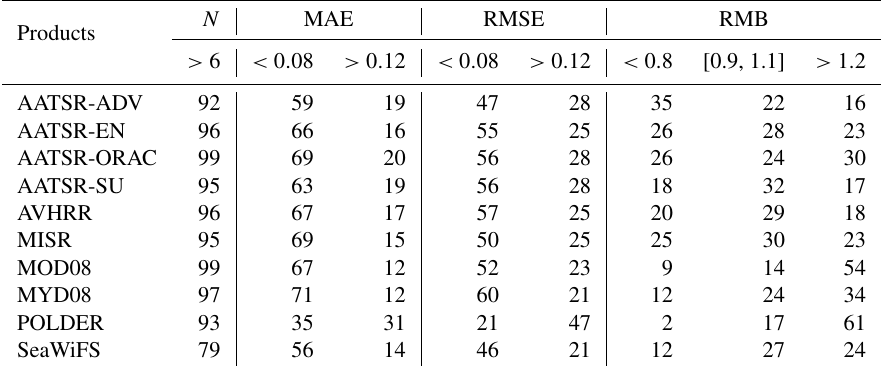
Table 2. Percentage of sites within certain ranges of evaluation metrics for different satellite-derived monthly AOD S products from 2006 to